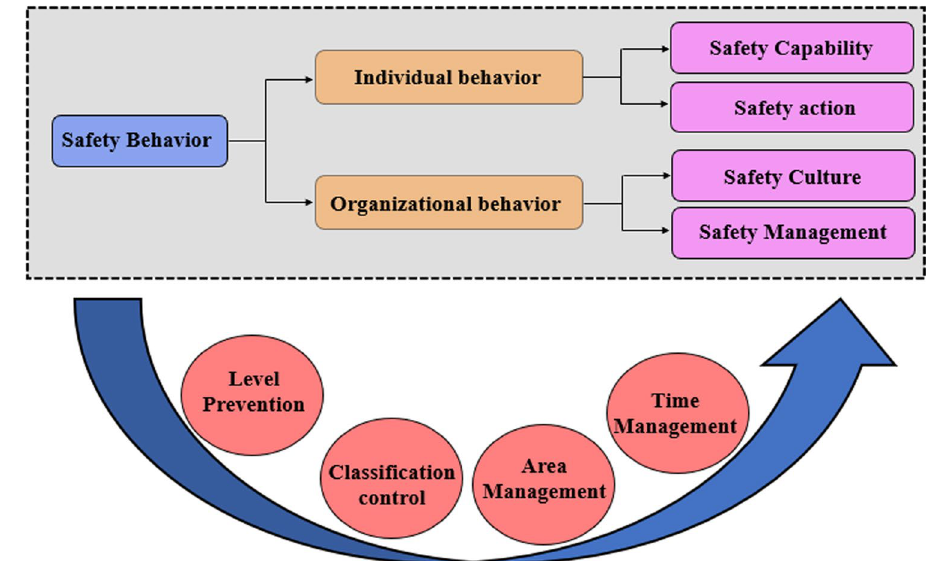
Fig. 13 Classification system for behaviors in “4 + 4”